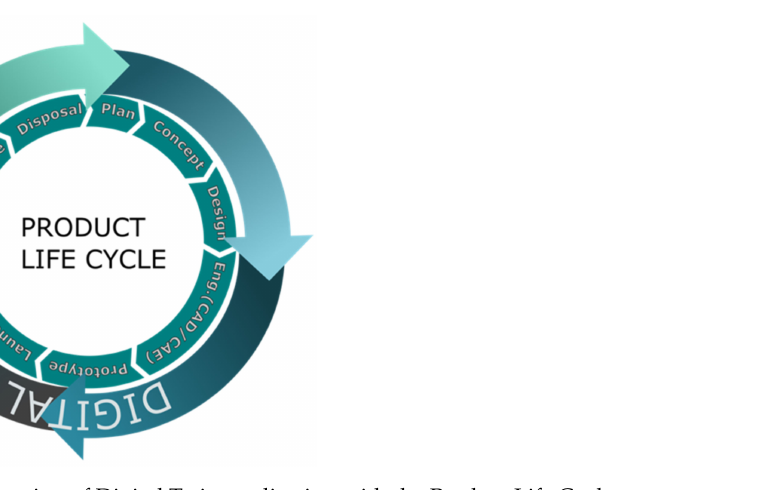
Figure 4. Integration of Digital Twin application with the Product Life Cycle management.